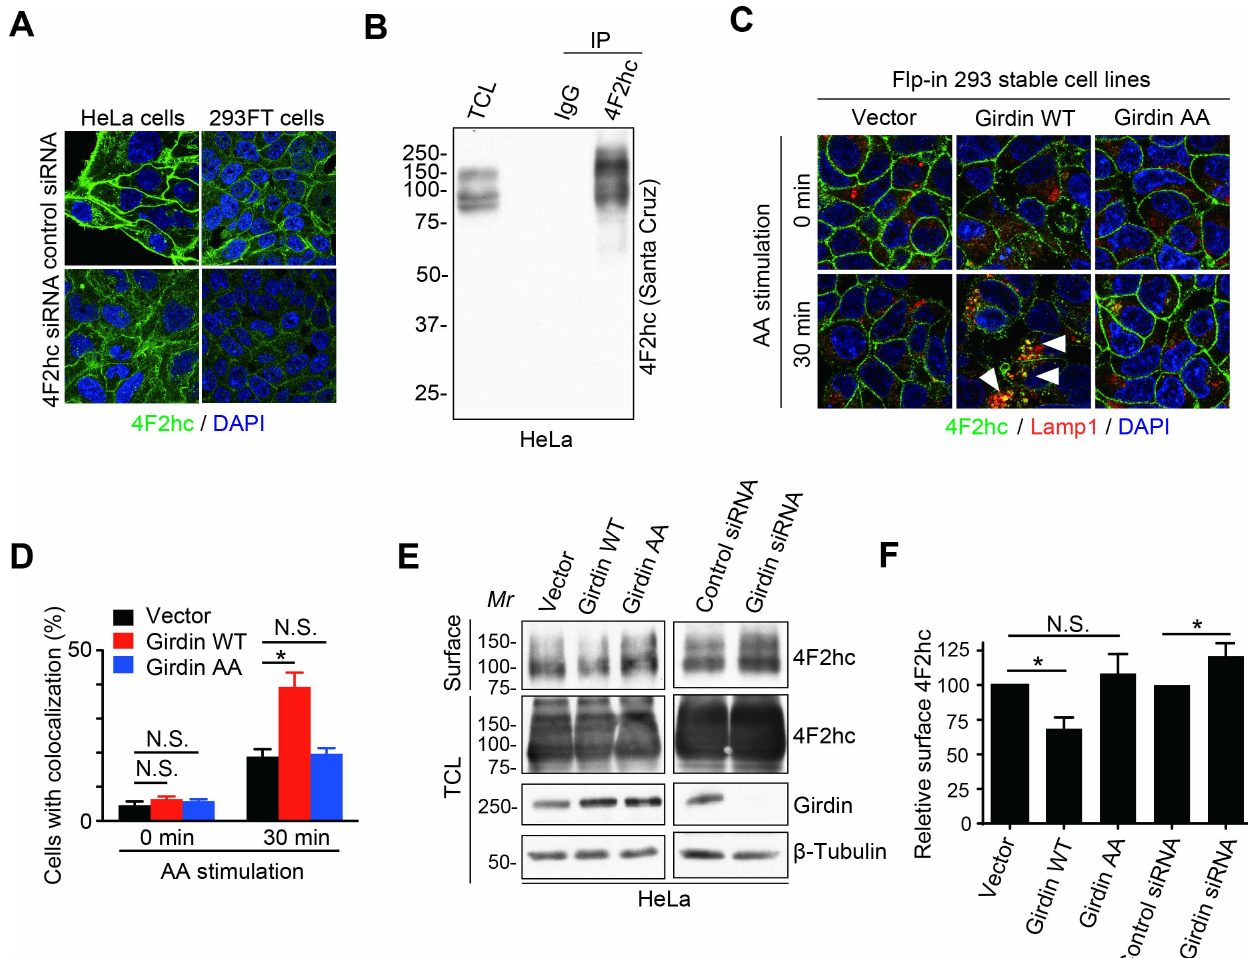
Fig 5. Girdin promotes 4F2hc translocation to the lysosomes. (A) In-house-developed 4F2hc antibody was used for IF in HeLa cells and 293FT cells; staining intensity was markedly reduced in 4F2hc knockdown cells. (B) In-house-developed 4F2hc antibody was used for IP in HeLa cells, and the sample was detected by commercial 4F2hc antibody to verify the quality of the antibody. (C) Flp-In 293 cells stably transduced with the indicated plasmids were starved for amino acids for 1 h and stimulated with amino acids for 30 min, followed by immunofluorescence staining for 4F2hc (green) and Lamp1 (red). Arrowheads indicate the localization of 4F2hc in the lysosome. (D) Quantification of the cells shown in (C) with 4F2hc localized on the lysosome (100 cells from three independent experiments). The data are presented as means ± SEs. (cid:3) P < 0.05. The data underlying this figure can be found in S1 Data. (E) Cell surface proteins of HeLa cells transfected with the indicated siRNAs or plasmids were biotinylated and isolated, followed by WB with the indicated antibodies. (F) Quantification of the bands intensity of cell surface 4F2hc from 3 independent experiments is shown. The data are presented as means ± SEs. (cid:3) P < 0.05. The value of the surface 4F2hc in the cells transfected with empty vector or control siRNA were set as 100. The data underlying this figure can be found in S1 Data. Girdin, girders of actin filaments; IgG, immunoglobulin G; Mr , molecular marker; N.S., not significant; siRNA; small interfering RNA; WB, western blot; WT, wild-type; 4F2hc, 4F2 heavy